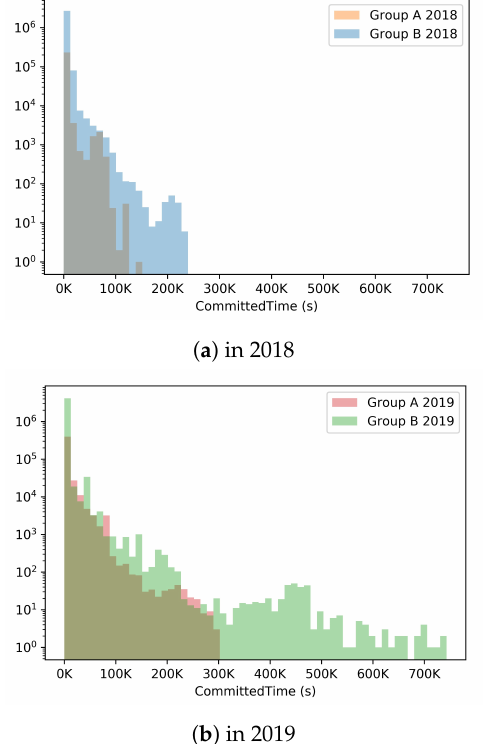
Figure 5. Individual job committed time